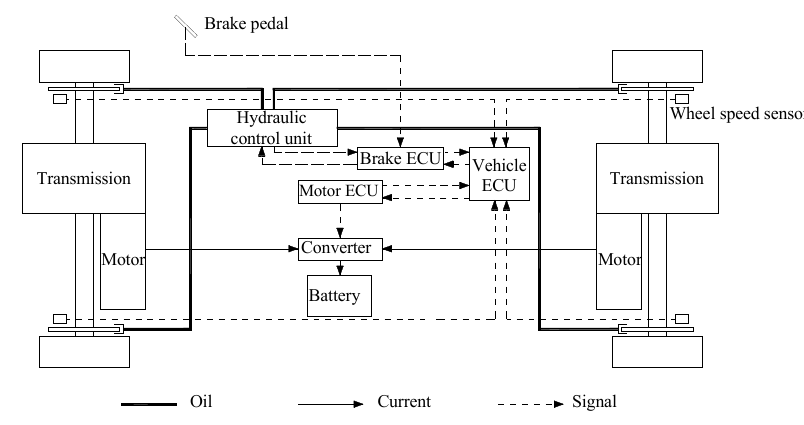
Figure 1. Regenerative braking control system.